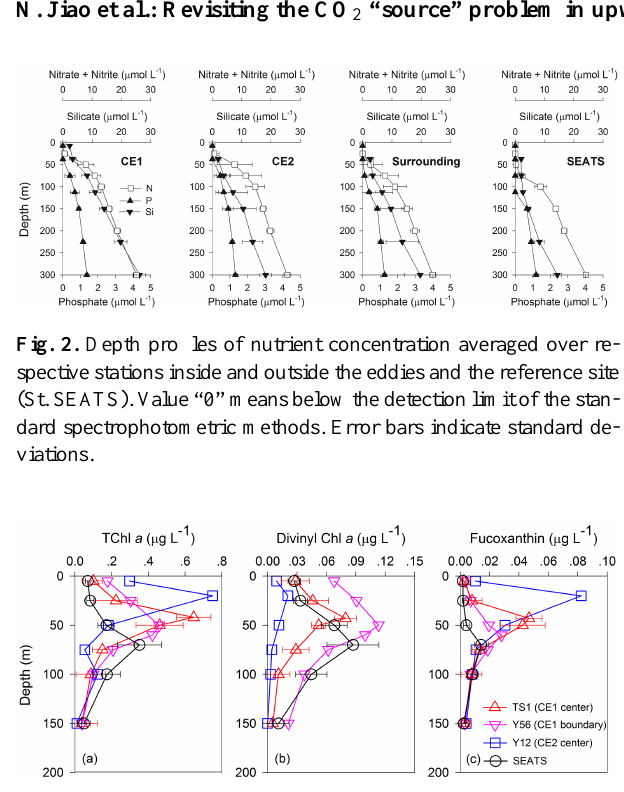
Fig. 3. Depth profiles of phytoplankton pigments at the eddy cen- ters (TS1 and Y12), the eddy edge (Y56) and the reference site (St. SEATS). Data are the average values over time series analysis at St. TS1 (N = 6) and SEATS (N = 7). Error bars indicate standard deviations. TChl a : total chlorophyll a .